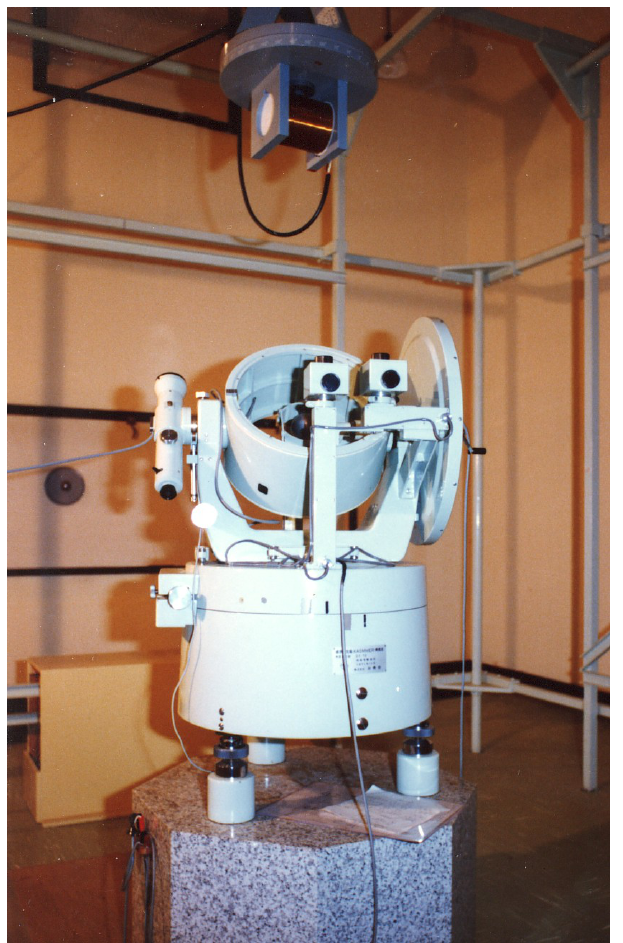
Figure 24. Newly developed theodolite DI-72 beneath a proton processor magnetometer (photo supplied by Kakioka Magnetic Ob-